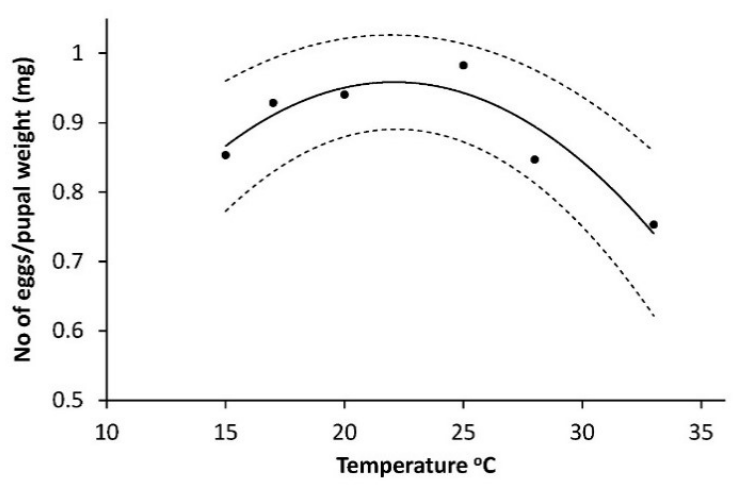
Figure 5. Temperature dependent egg number per mg pupal weight for Agrotis segetum pupae at eight different constant temperatures calculated as log 10 (N egg )/gram pupal weight = 0.0630077616 + 0.08108075T − 0.001835228T 2 , R 2 = 0.866, F 2,3 = 11.4, p = 0.049. The dashed lines above and below